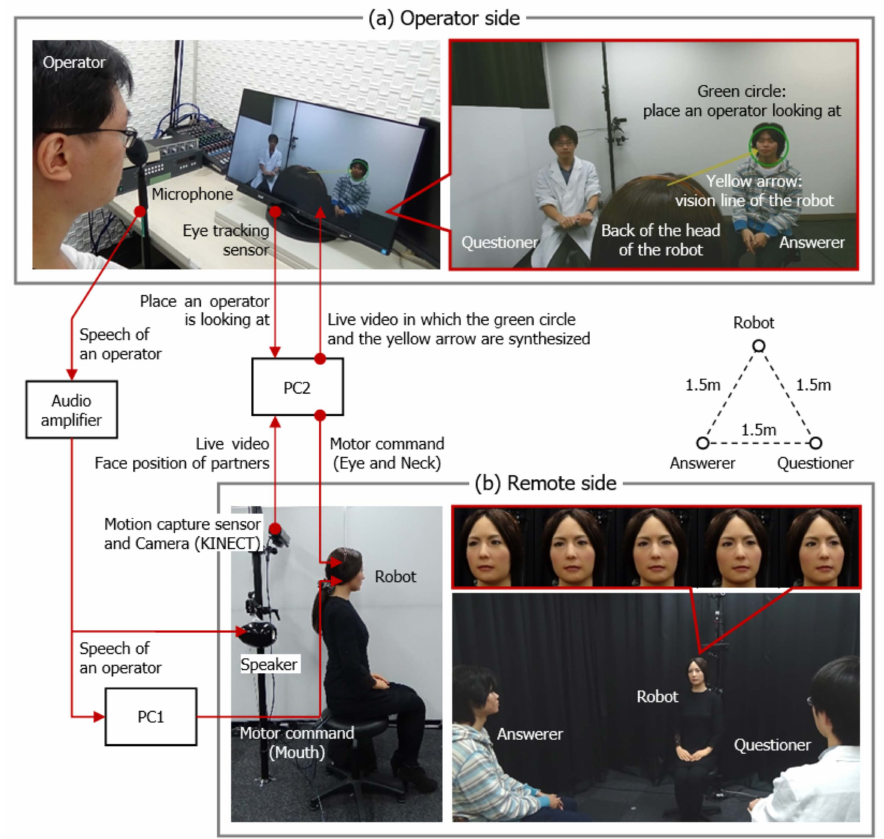
Figure 1. Experimental setup of the operator and remote